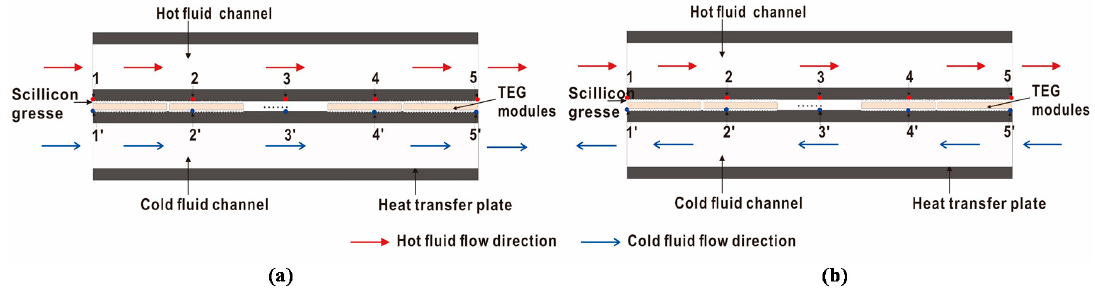
Figure 11. Fluid flow direction diagram: ( a ) Co-current; ( b ) Counter current (The dots in diagram are testing points).